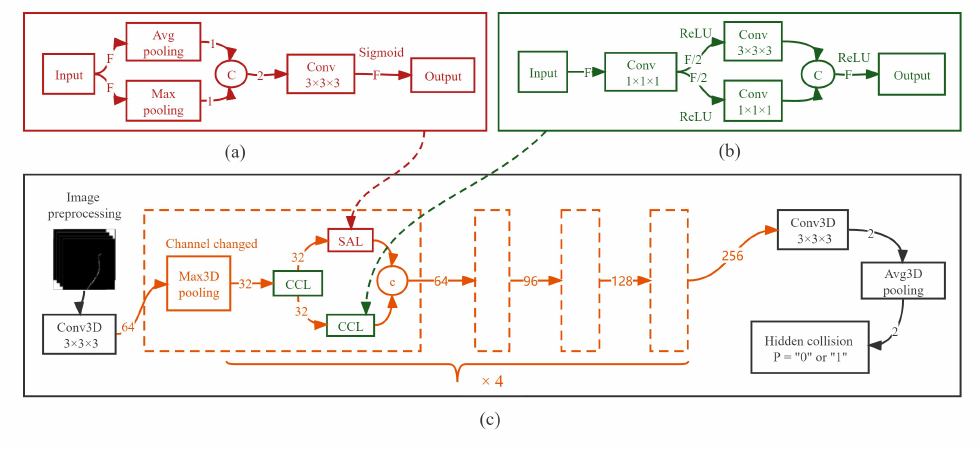
Figure 6. The GCCM-net model accepts the preprocessed frames of the guidewire outline and outputs the probability value of the hidden collision. A complete GCCM-net contains four repeated and serial modules. Each module contains two CCLs and one SAL. There is a 3D Maxpooling layer in front of the module to adjust the number of channels F. The input data have a size of (B, F, x, y, z), where B represents the number of batches, F represents the number of feature channels, and x, y, z are from four consecutive frames of images. ( a ) Spatial attention layer (SAL). ( b ) Compression convolution layer (CCL). ( c ) Deep learning network in guidewire compliant control method